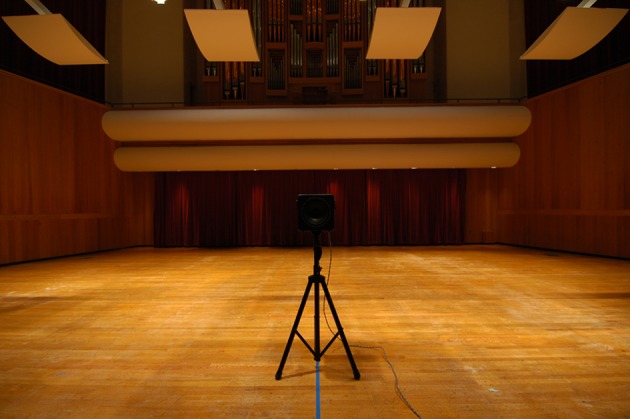
Visual stimulus example. A photograph of the measurement loudspeaker was taken at each distance from where the KEMAR mannequin was placed during BRIR measurement at the front of the stage. In the V and A+V conditions a photograph was presented on a large flat screen HDTV and the participant provided a distance judgment to the sound source. In this example, the measurement loudspeaker is placed 2.44 m in front of the camera in Comstock Hall.